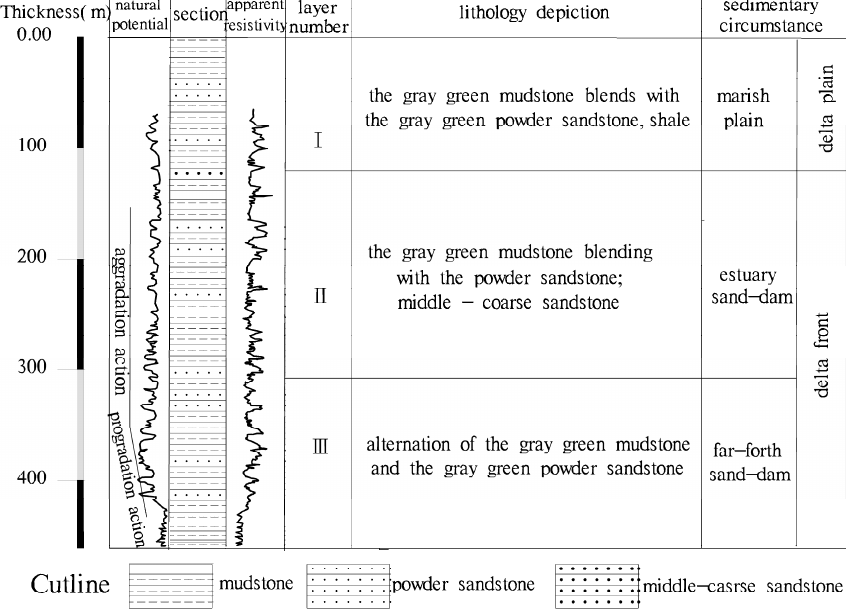
Figure 3. Dongying sedimentary faces analysis represented vertically.